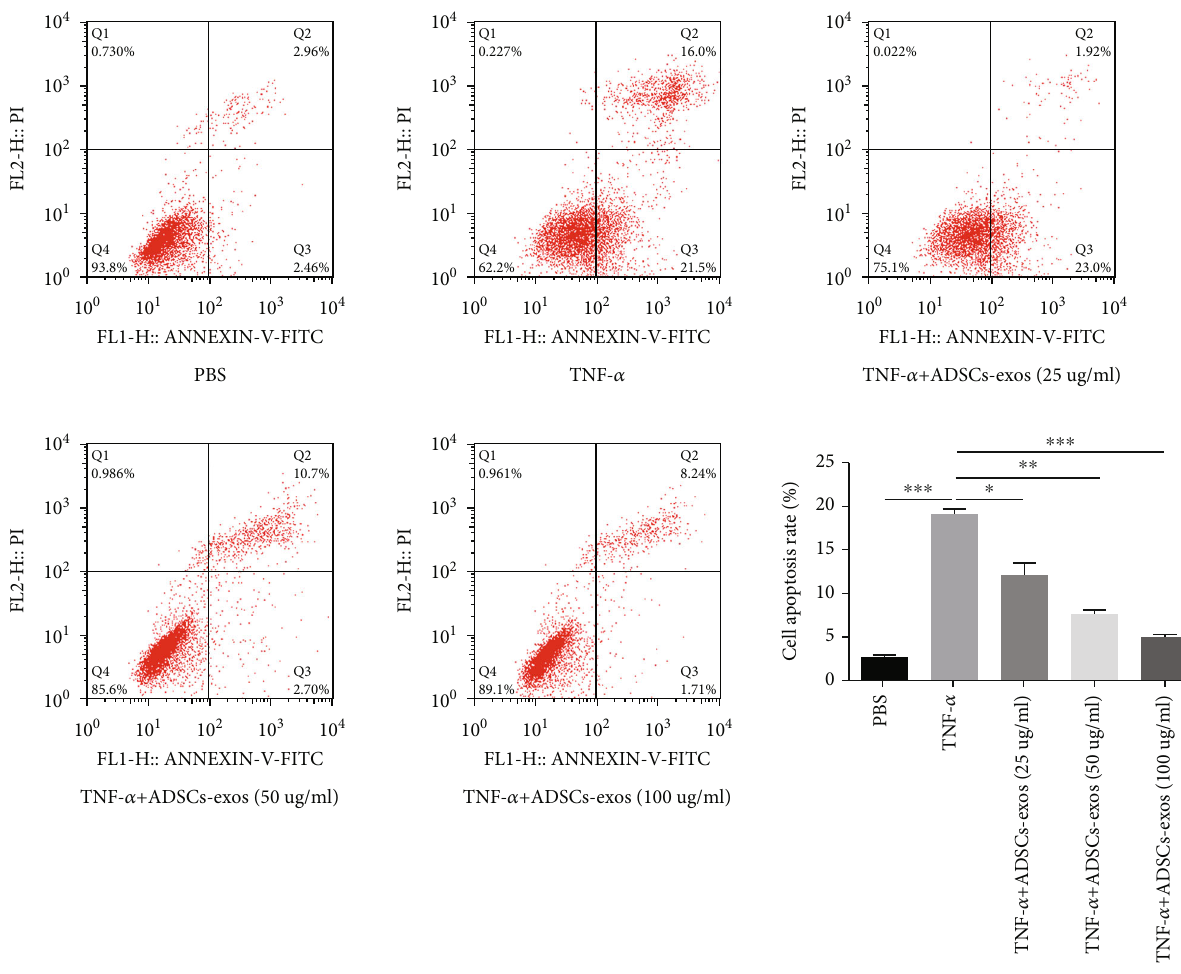
Figure 4: ADSCs-Exos attenuate the e ff ect of TNF- α on primary osteoblasts. (a) ADSCs-Exos attenuated the upregulation of miR-141-5p induced by TNF- α dose-dependently. (b) ADSCs-Exos mitigated the inhibition of TNF- α on cell viability in a dose-dependent manner. (c) ADSCs-Exos dose-dependently decreased the promotion of TNF- α on cleaved caspase-3 and Bax expression. (d) Flow cytometry analysis showed that ADSCs-Exos dose-dependently reversed TNF- α -induced cell apoptosis. ∗ P < 0 : 05 , ∗∗ P < 0 : 01 , and ∗∗∗ P < 0 : 001 KCNQ1OT1-Exos (Figure 5(c)). Next, to explore whether indicated ADSCs-Exos dose-dependently blocked cell apo- KCNQ1OT1-Exos could in fl uence TNF- α -induced cyto- ptosis induced by TNF- α (Figure 4(d)). toxicity and apoptosis, primary osteoblasts were treated with TNF- α and then cocultured with medium, ADSCs- 3.5. KCNQ1OT1-Exos Inhibit TNF- α -Induced Cytotoxicity Exos, LV-NC-Exos, or LV-KCNQ1OT1-Exos. The results and Apoptosis of Primary Osteoblasts. ADSCs were trans- of CCK-8 showed the coculture of primary osteoblasts fected with LV-KCNQ1OT1 or LV-NC for the determina- with LV-KCNQ1OT1-Exos mitigated the negative e ff ect tion of whether ADSCs transfected LV-KCNQ1OT1 into of TNF- α on cell viability; ADSCs-Exos exerted a weaker secreted exosomes. At 24 h post-LV-KCNQ1OT1 transfec- stimulative e ff ect on cell viability compared to LV- tion, the expression of KCNQ1OT1 in ADSCs or exo- KCNQ1OT1-Exos (Figure 5(d)). Flow cytometry analysis somes derived from the ADSCs after di ff erent indicated that TNF- α -induced cell apoptosis was reversed transfections was elevated, but the expression of miR- when primary osteoblasts were cocultured with LV- 141-5p was downregulated compared with that in LV- KCNQ1OT1-Exos; ADSCs-Exos exerted a weaker inhibi- NC-treated group (Figures 5(a) and 5(b)). In order to con- fi rm whether ADSCs-Exos carrying LV-KCNQ1OT1 could tory e ff ect on cell apoptosis compared to LV- KCNQ1OT1-Exos (Figure 5(e)). Consistent with that, the deliver KCNQ1OT1 into primary osteoblasts, primary expression of Bax and cleaved caspase-3 in primary osteo- osteoblasts were cocultured with LV-NC-Exos or LV- blasts was blocked after coculture of LV-KCNQ1OT1-Exos KCNQ1OT1-Exos. KCNQ1OT1 expression was upregu- (Figure 5(f)). lated in primary osteoblasts treated with LV-